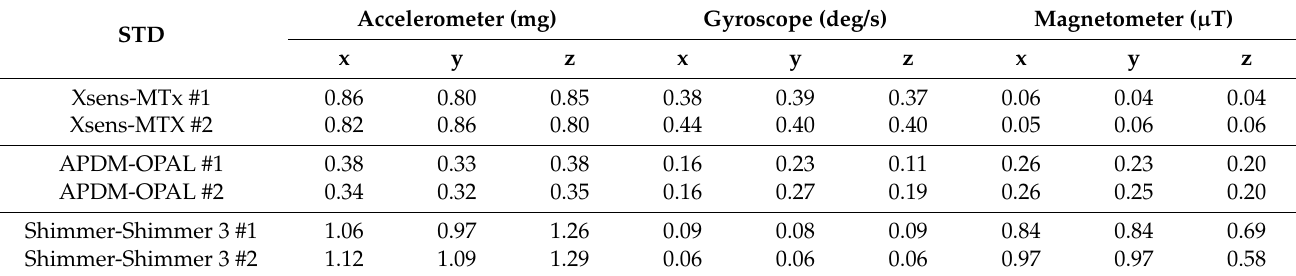
Table A3. Sensor STD Computed during One Minute of Static Acquisition.